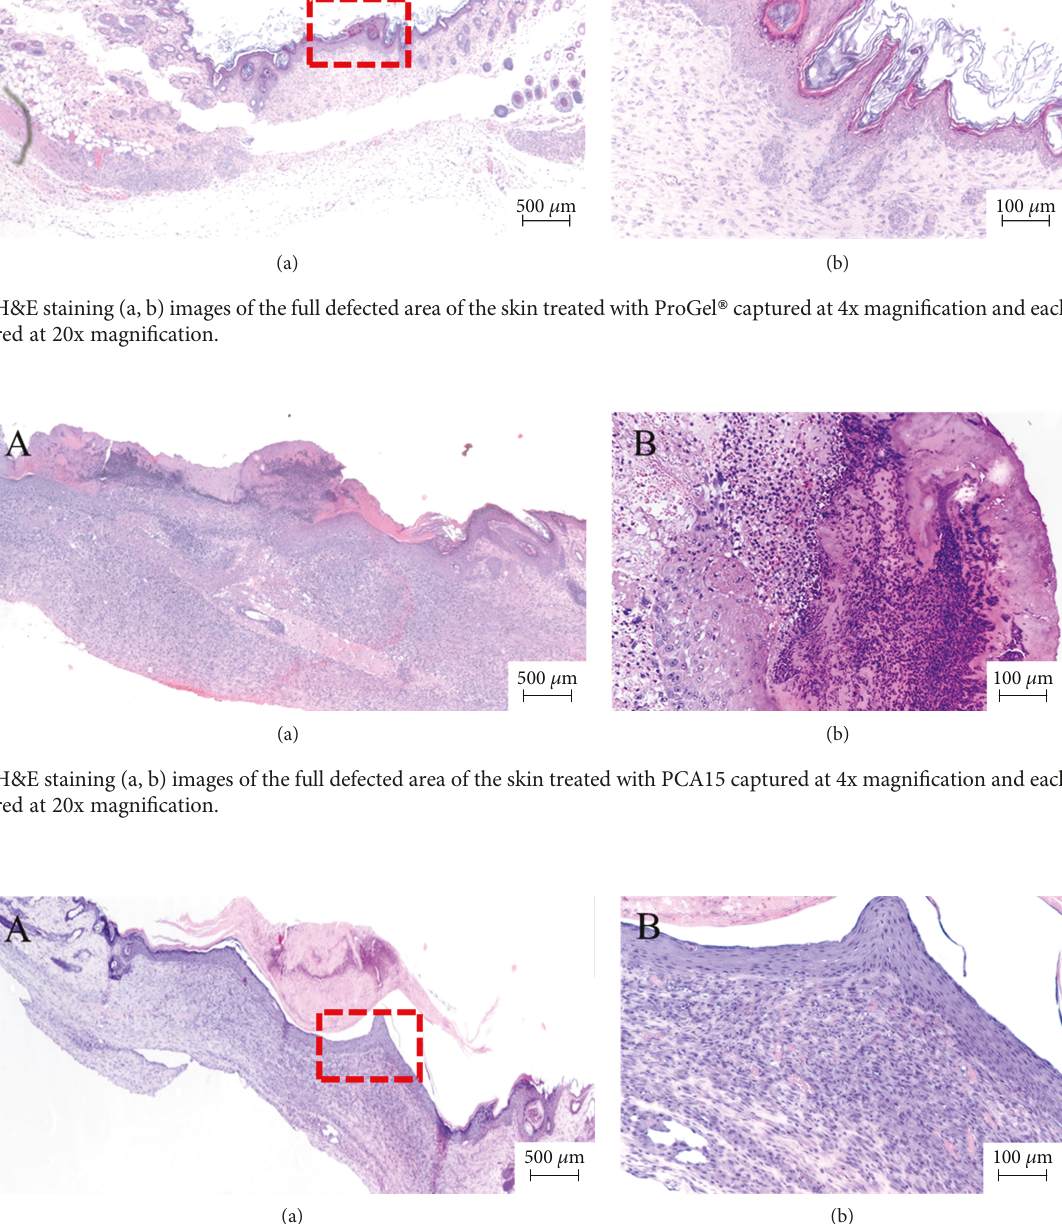
Figure 9: H&E staining (a, b) images of the full defected area of the skin treated with PCA30 captured at 4x magni fi cation and each enlarged part captured at 20x magni fi